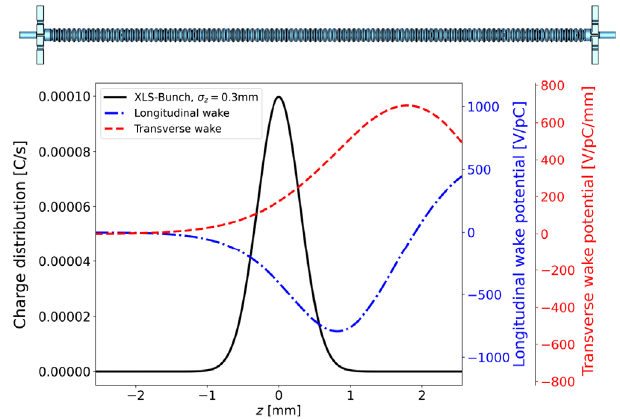
FIG. 18. Side view of the simulated 30-cm TWS (top). The magnitude of the longitudinal (dash-dotted blue line) and trans- verse (dashed red line) short-range wakefields (bottom), for a single 300 μ m, 75 pC electron